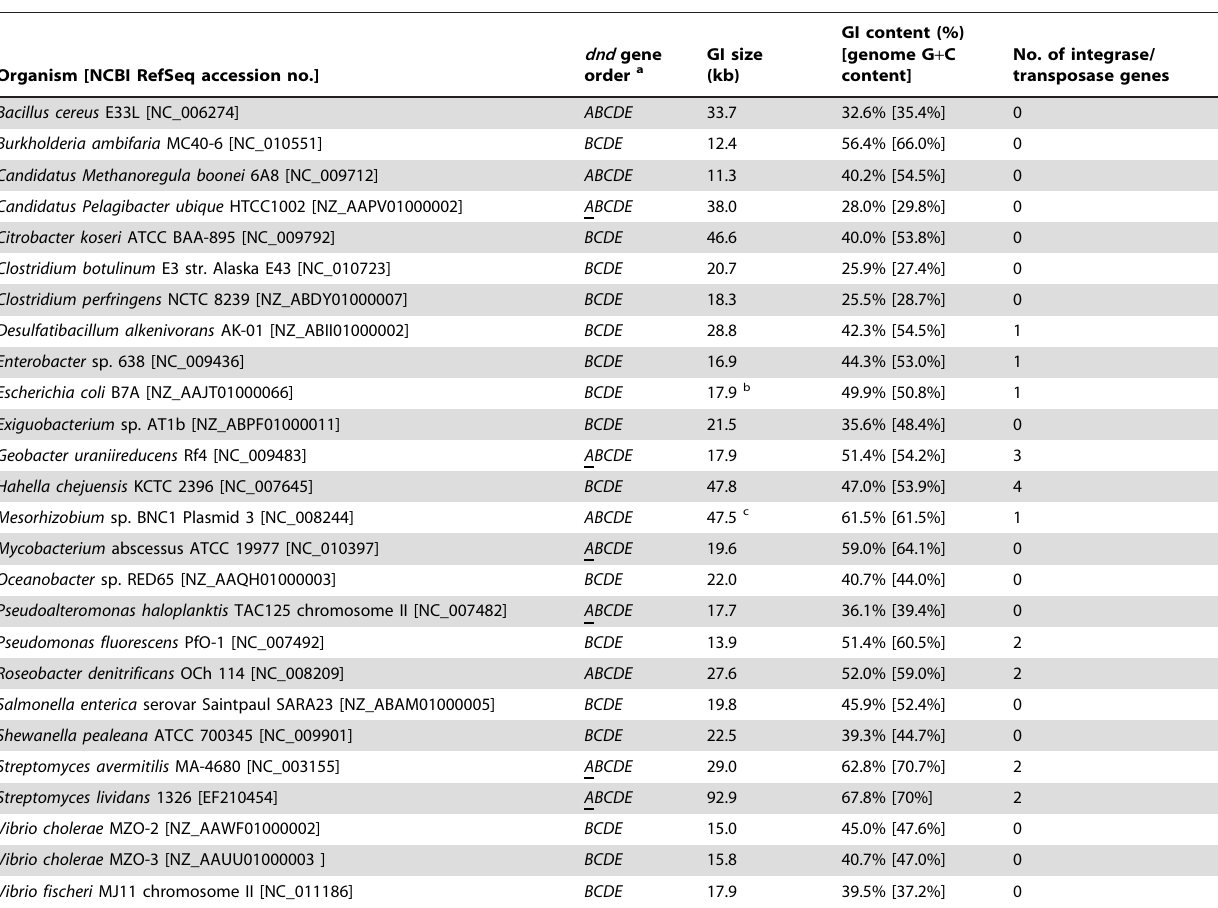
Table 1. dnd clusters present on mobile genetic elements comprising 25 genomic islands and one plasmid